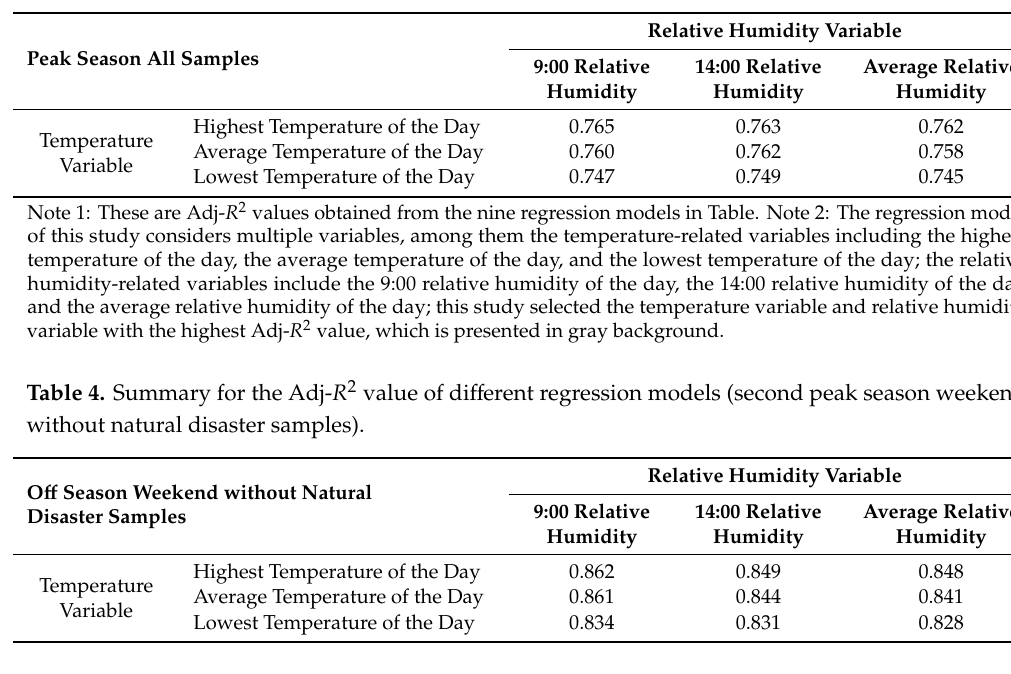
Figure 9. Explanation of a total of 9 models for the tourist seasons and sample types. Table 3. Summary for the Adj- R 2 value of different regression models (peak season all samples).